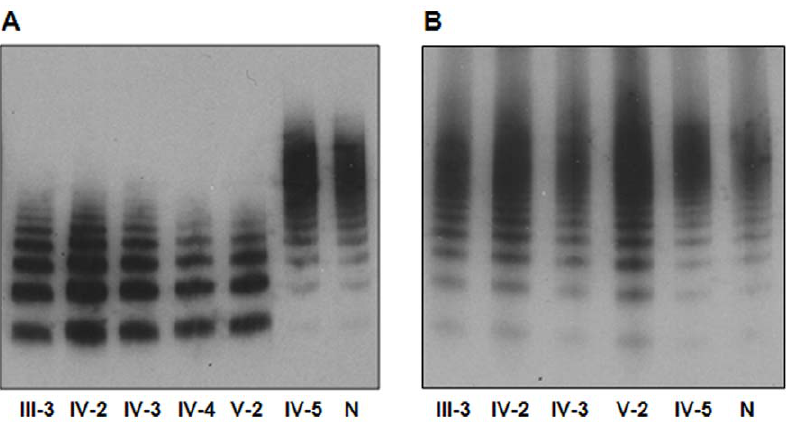
Figure 2. Analysis of plasma and platelet VWF multimers. Plasma (A) and platelet (B) VWF multimers were assessed by 1.6% SDS-agarose gel electrophoresis and Western blotting. Normal plasma samples were diluted 1:20 and patient plasma samples were diluted 1:5. Samples from family members and a normal control (N) were indicated. Platelet samples were not available from IV-4.